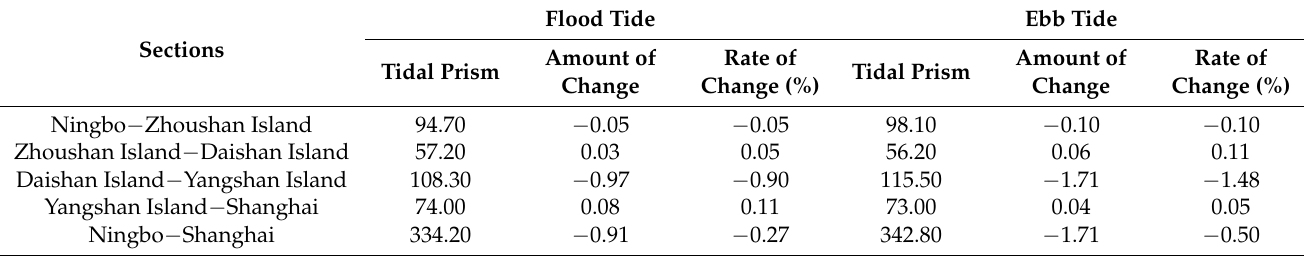
Table 2. Variation in tidal prisms (10 8 m 3 ).